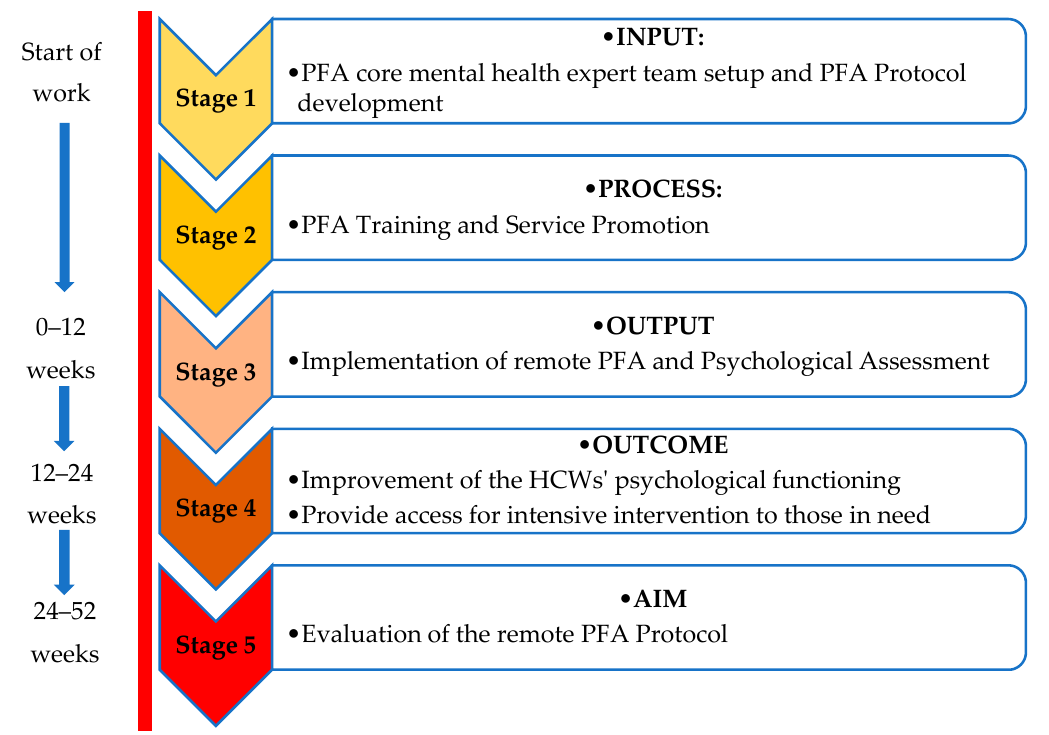
Figure 1. Hierarchy of goals of the remote Psychological First Aid (PFA) protocol for Healthcare Workers (HCWs) to be achieved in stages within a set timeframe during the COVID-19 pandemic in University Malaya Medical Centre (UMMC) (adapted from Ogbeiwi, 2017).